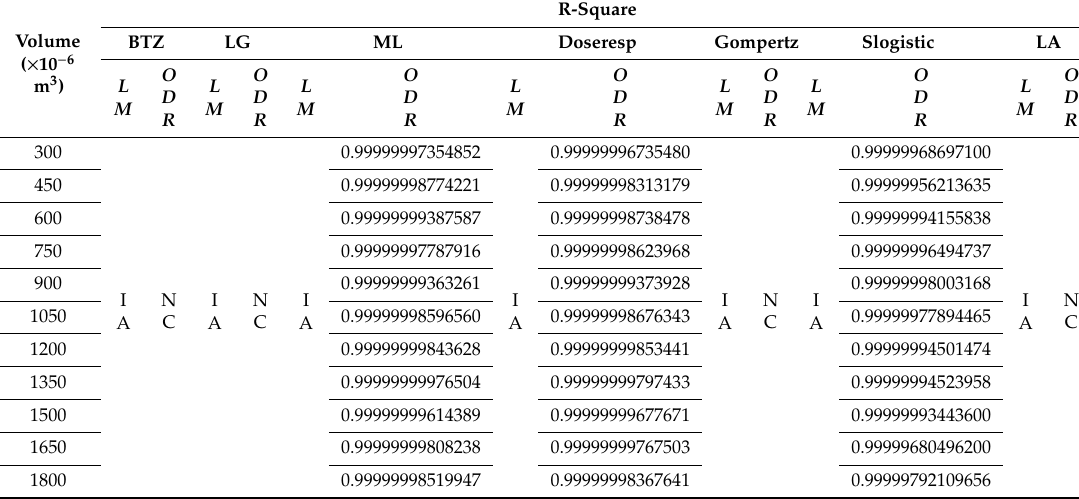
Table 3. R-Square of the non-linear adjustments.